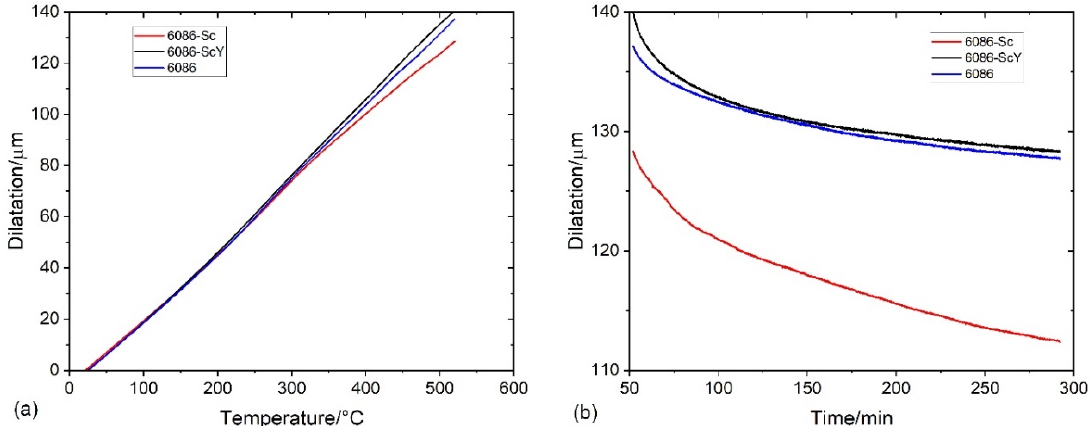
Figure 5. Dilatation of the investigated alloys ( a ) during heating from RT to 520 °C with 10 °C/min, and ( b ) during holding at 520 °C for 4 h.